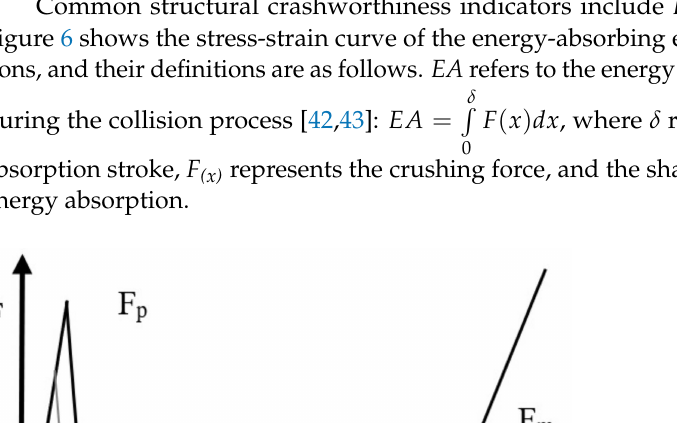
. where m . F p is the δ . F p